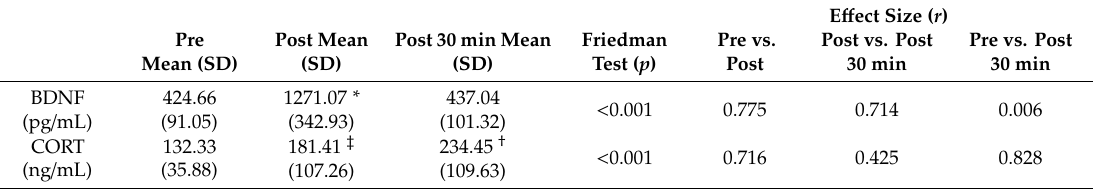
E ff ect Size ( r )